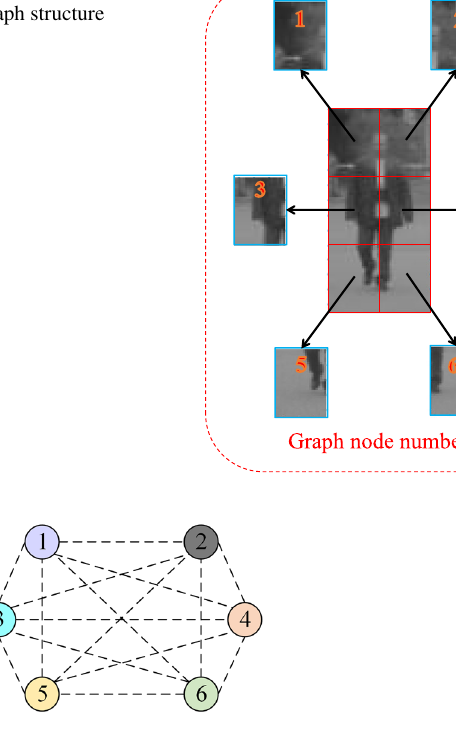
Fig. 4 Graph structure with standard adjacency matrix